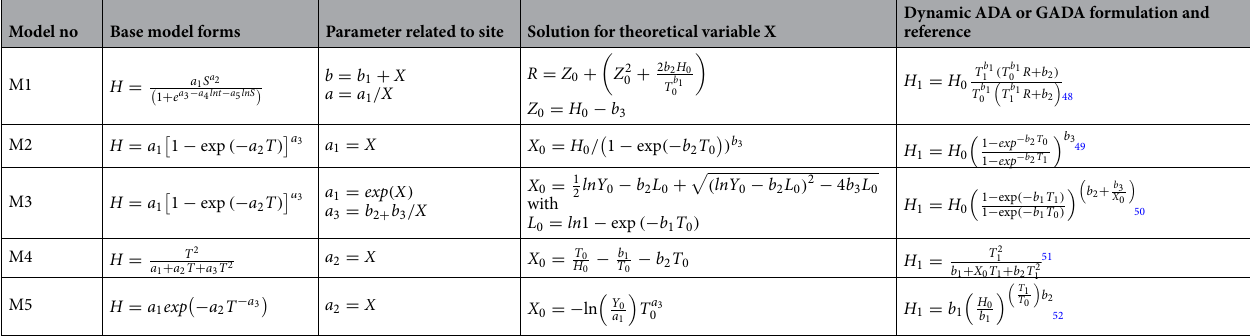
within-group errors was analysed using corAR1 and corARMA(10,0) function from nlme R package respectively 41 with RStudio software 45 .